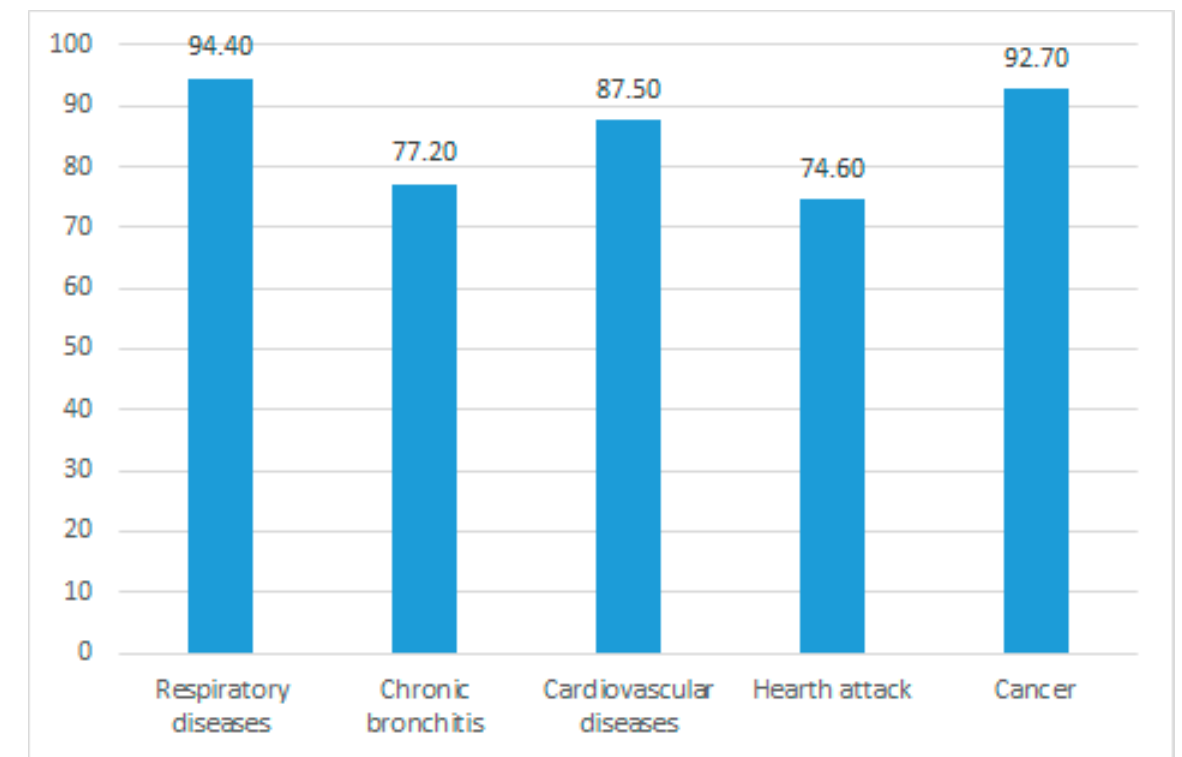
Figure 1. Knowledge about diseases related to smoking habits.